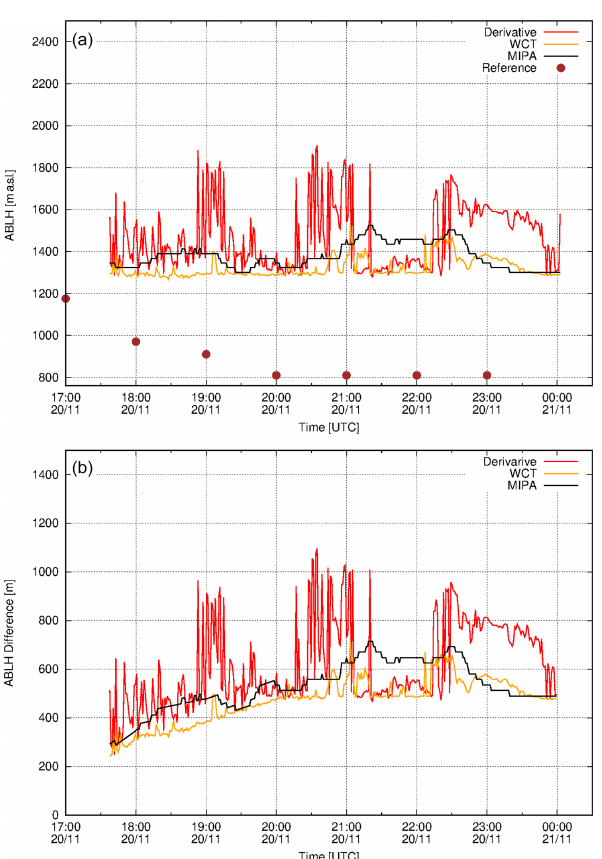
Figure 9. (a) ABLH retrieved from the Potenza lidar measurements on 20 November 2014. Black, red and yellow lines show the ABLH retrieved from 1064nm high-resolution total attenuated backscat- ter time series applying MIPA, derivative and WCT algorithms, respectively. Brown circles are the reference ABLHs as retrieved from atmospheric temperature and pressure profiles provided by ECMWF forecasts. (b) Absolute differences between the retrieved ABLHs with respect to the reference. The original time resolution of ECMWF forecasts data is 1h. They have been interpolated at the lidar data time resolution